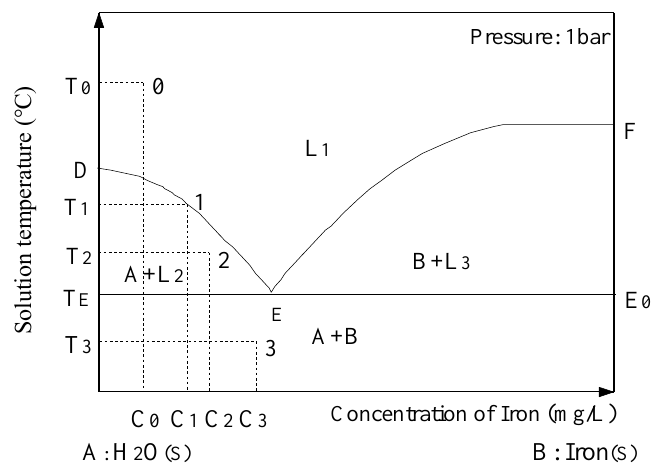
Figure 3. A schematic diagram of the solution’s temperature–concentration phase equilibrium curve.